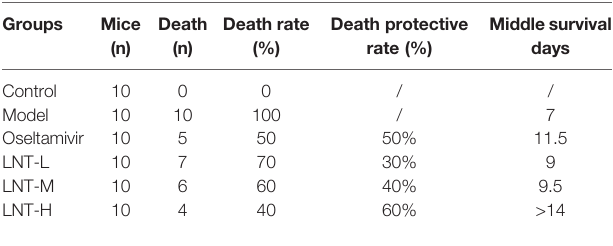
TABLE 2 | The protective effect of Lentinan on infected mice.